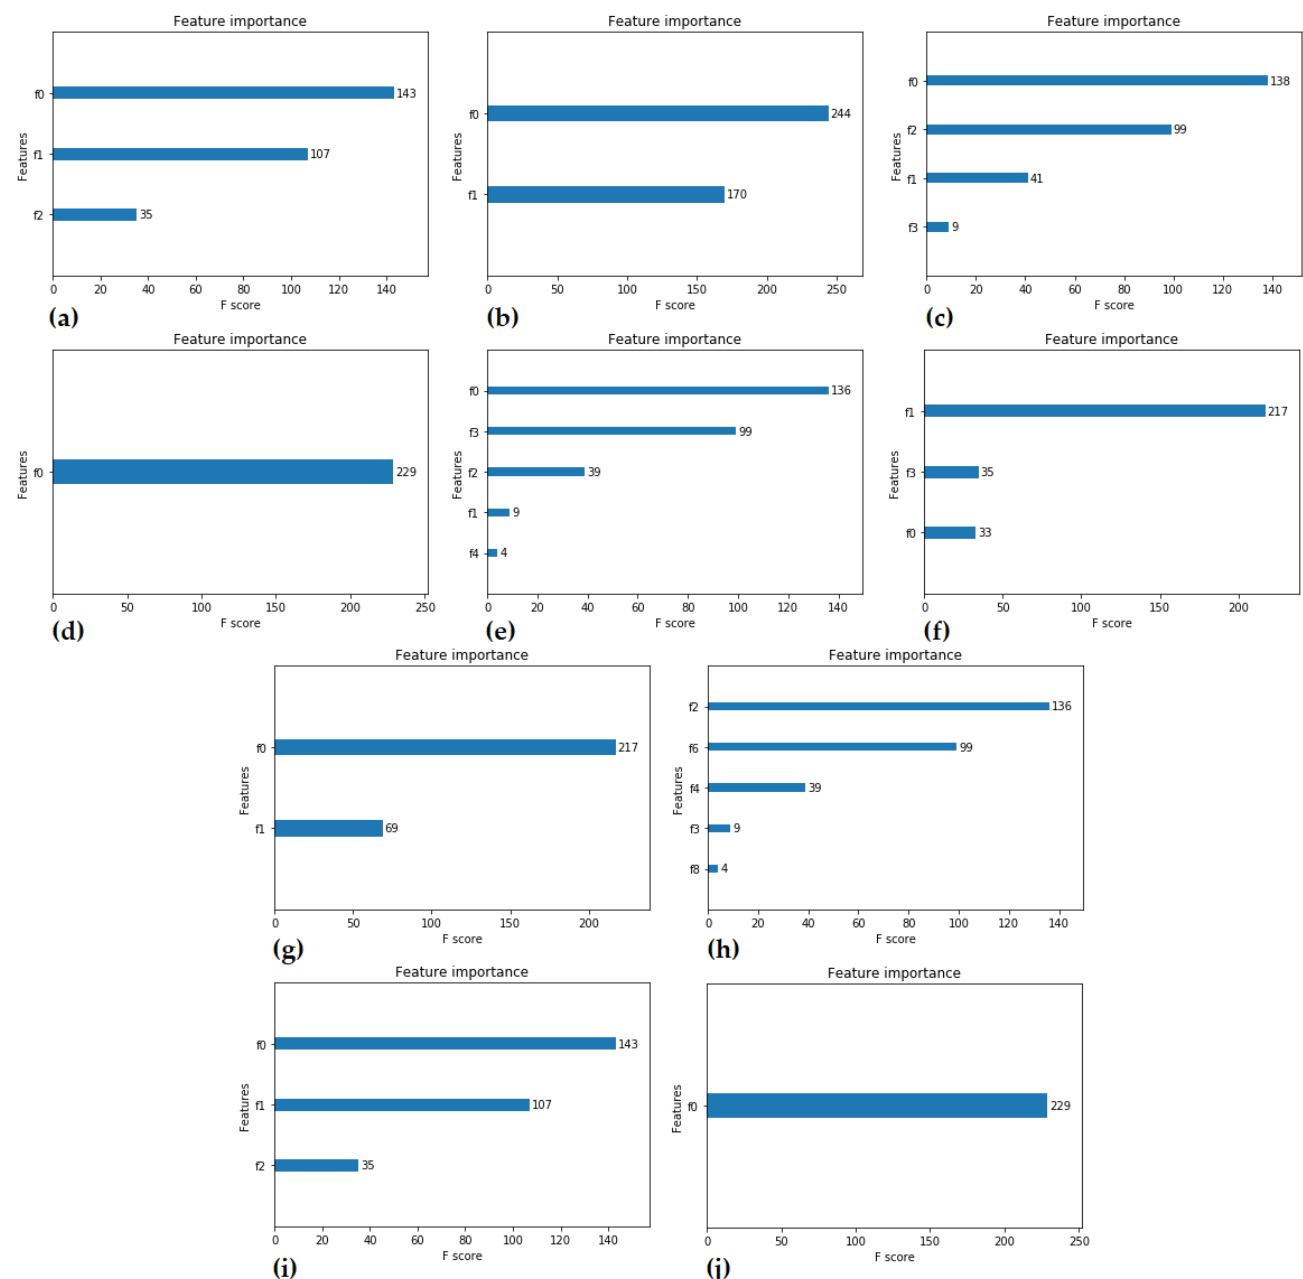
Figure 3. Feature importance by using XGBoost based on F-scores for the selected attributes via used feature-selection techniques, (a – d) The selected features for SFM using RF, LR, GB, DT, (e , f) for SKB using Chi2, FCI, (g – j) attributes selection for RFE using RF, LR, GB, DT, respectively.